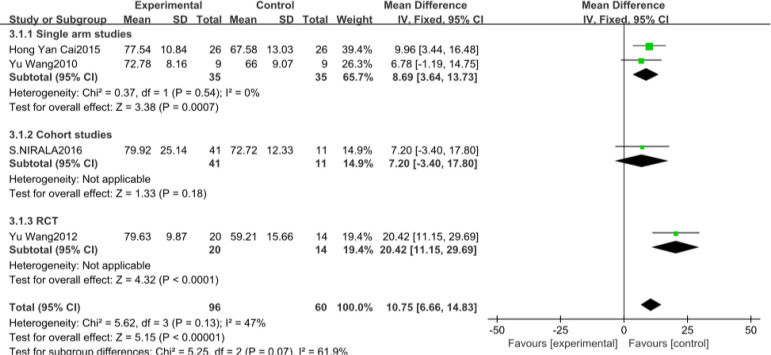
Forest map for the Seattle Angina Questionnaire of the cardiac short wave therapy group and the control group. CI=confidence interval; IV=inverse variance methods; RCT=randomised controlled trial; SD=standard deviation